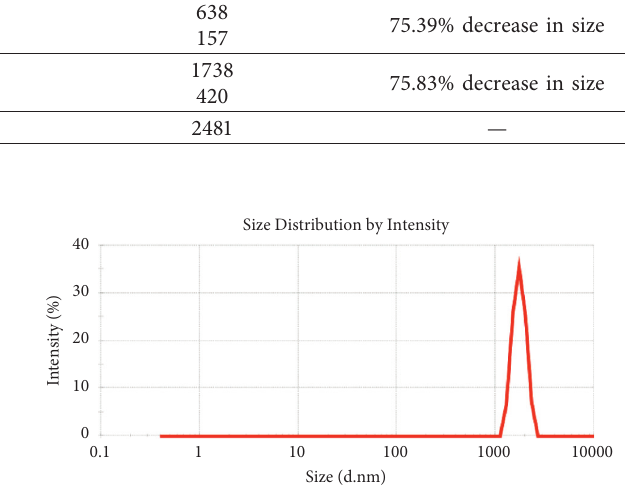
Figure 9: Particle size distribution graph of UGMK.